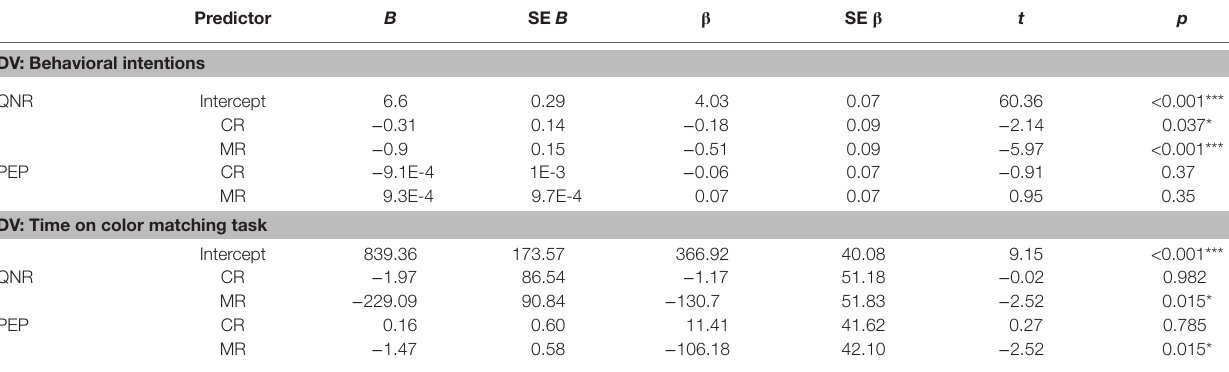
TABLE 3 | Multiple regressions for behavioral intentions (top) and time spent on color matching task (bottom) on PEP- and questionnaire-based (QNR) Classic and Modern Racism in Experiment 2 (CR = Classic Racism, MR = Modern Racism). Predictor B SE B β SE